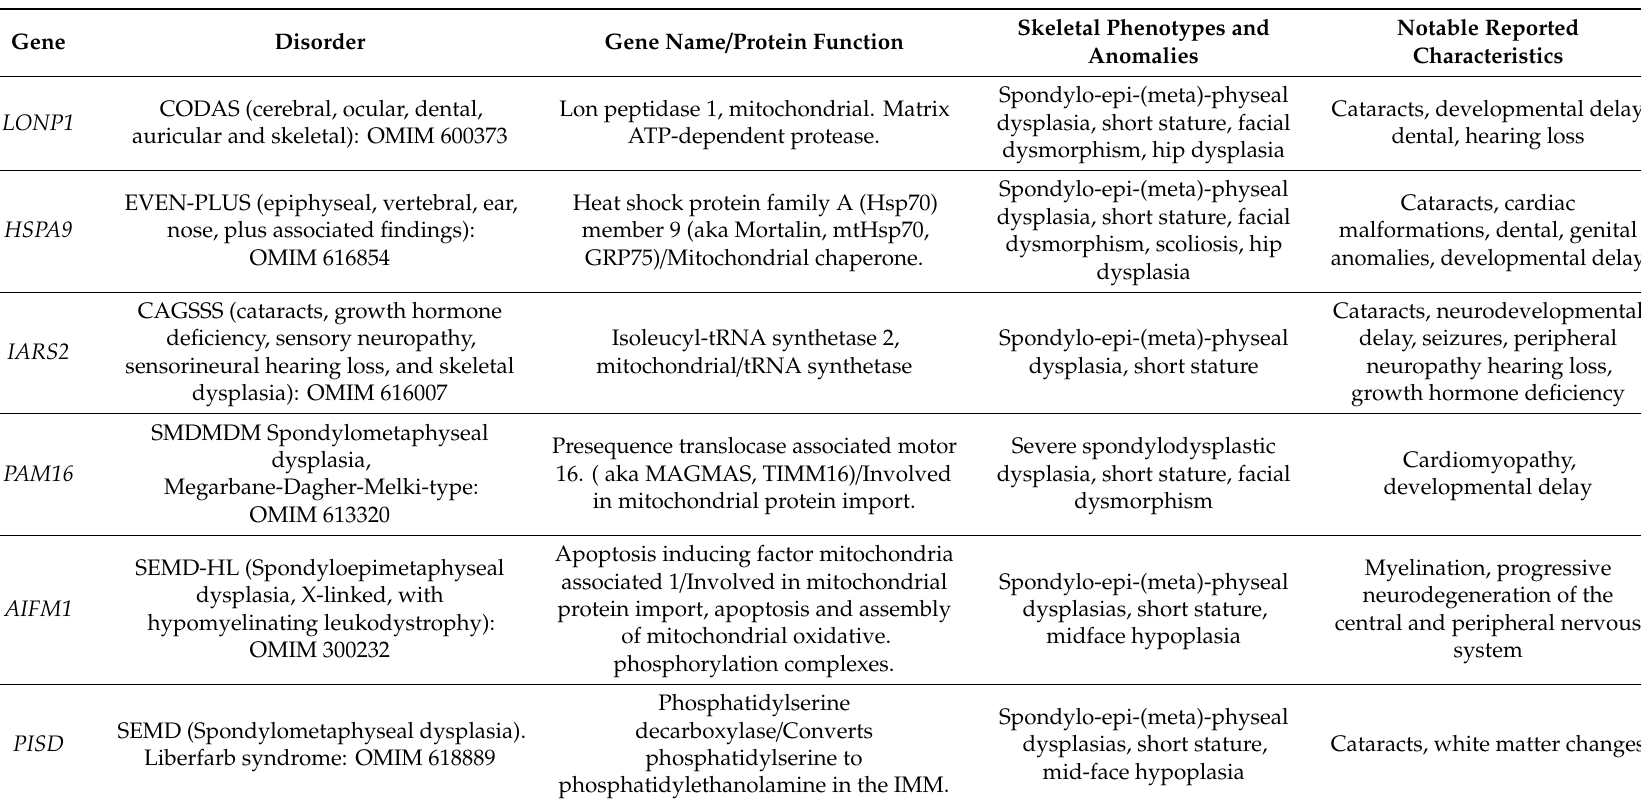
Table 1. Genes implicated in mitochondrial skeletal disorders, indicating formal OMIM (Online Mendelian Inheritance in Man) disease designations, gene names, protein functions, and phenotypic